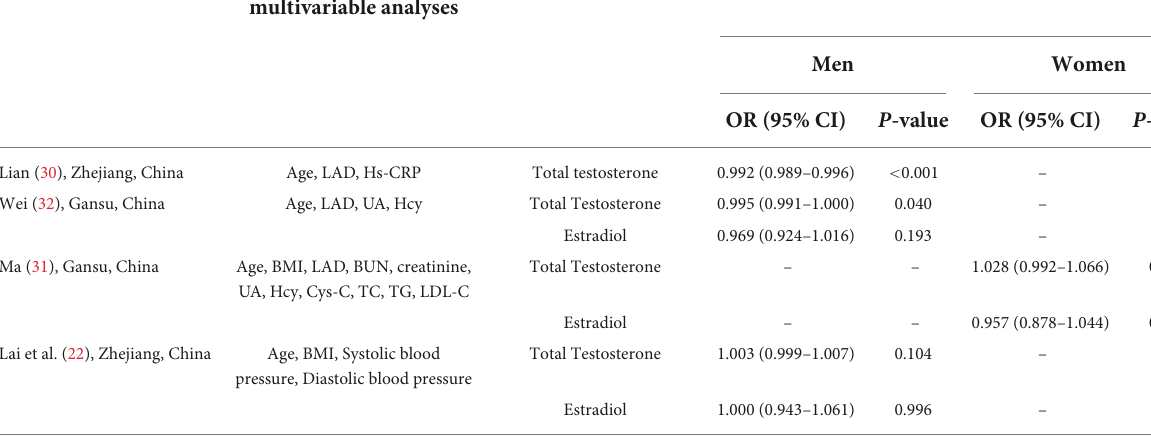
TABLE 4 Main sex hormones measured in the included case-control studies. Reference, region Confounding factor for multivariable analyses